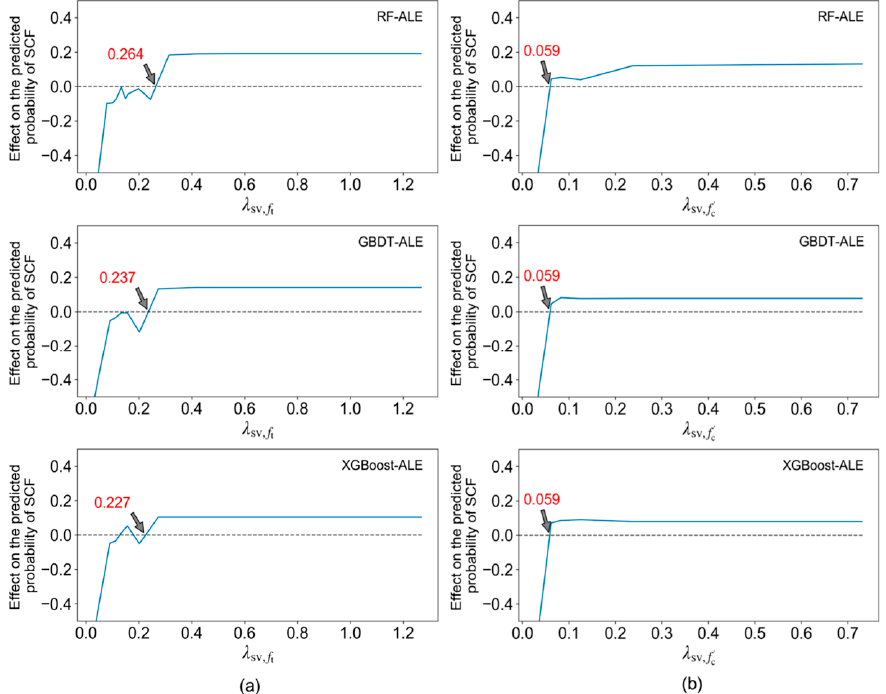
Figure 9. ALE plots of λ sv, f or λ sv, f (cid:48) based on RF-ALE, GBDT-ALE, and XGBoost-ALE (Note: The vertical axis indicates centered effect on prediction). ( a )ALE plots for λ sv, f